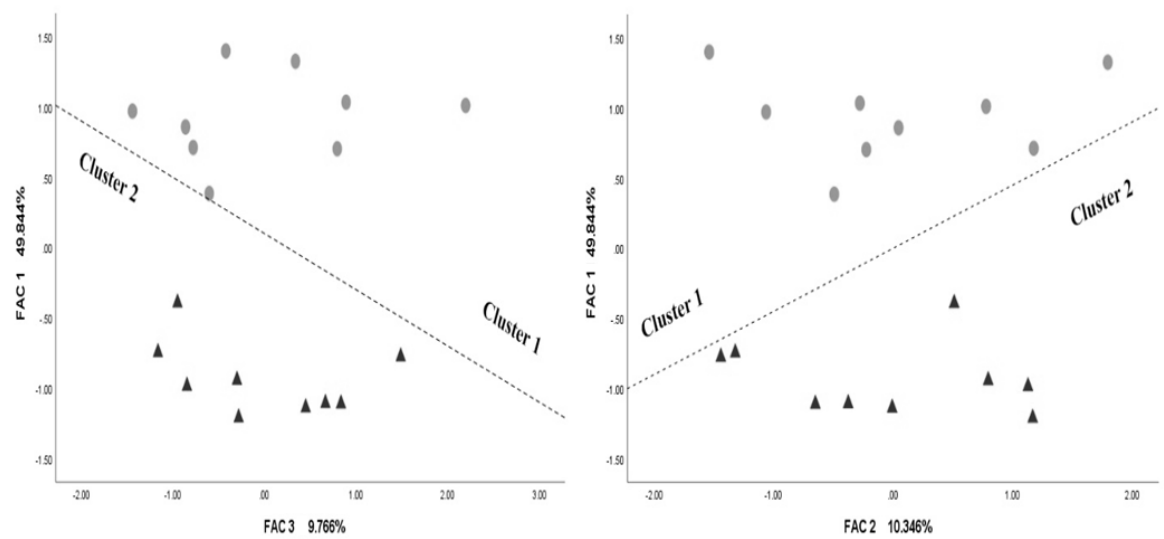
Fig. 4. PCA (fac1: fac2 and fac1: fac3) in 18 populations of N. complanata and N. crispa between clusters one and two based on quantitative character. This result separated two species into two clusters. The circle forms are related to N. crispa populations and square shapes related to N. complanata